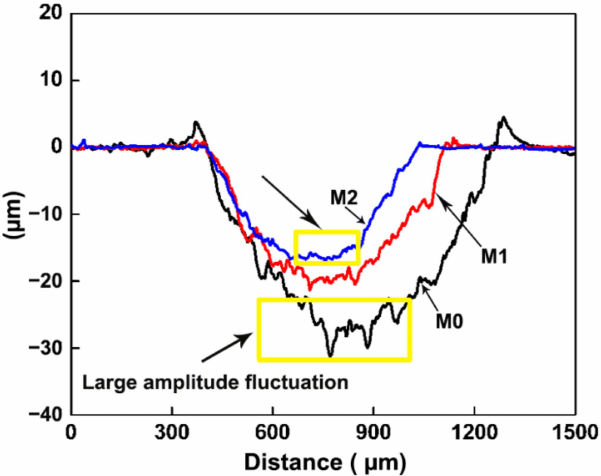
Figure 6. Wear track profiles of all fabricated